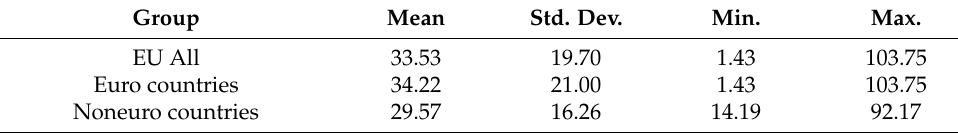
Table 2. Statistical values for BB depending on the groups of countries.